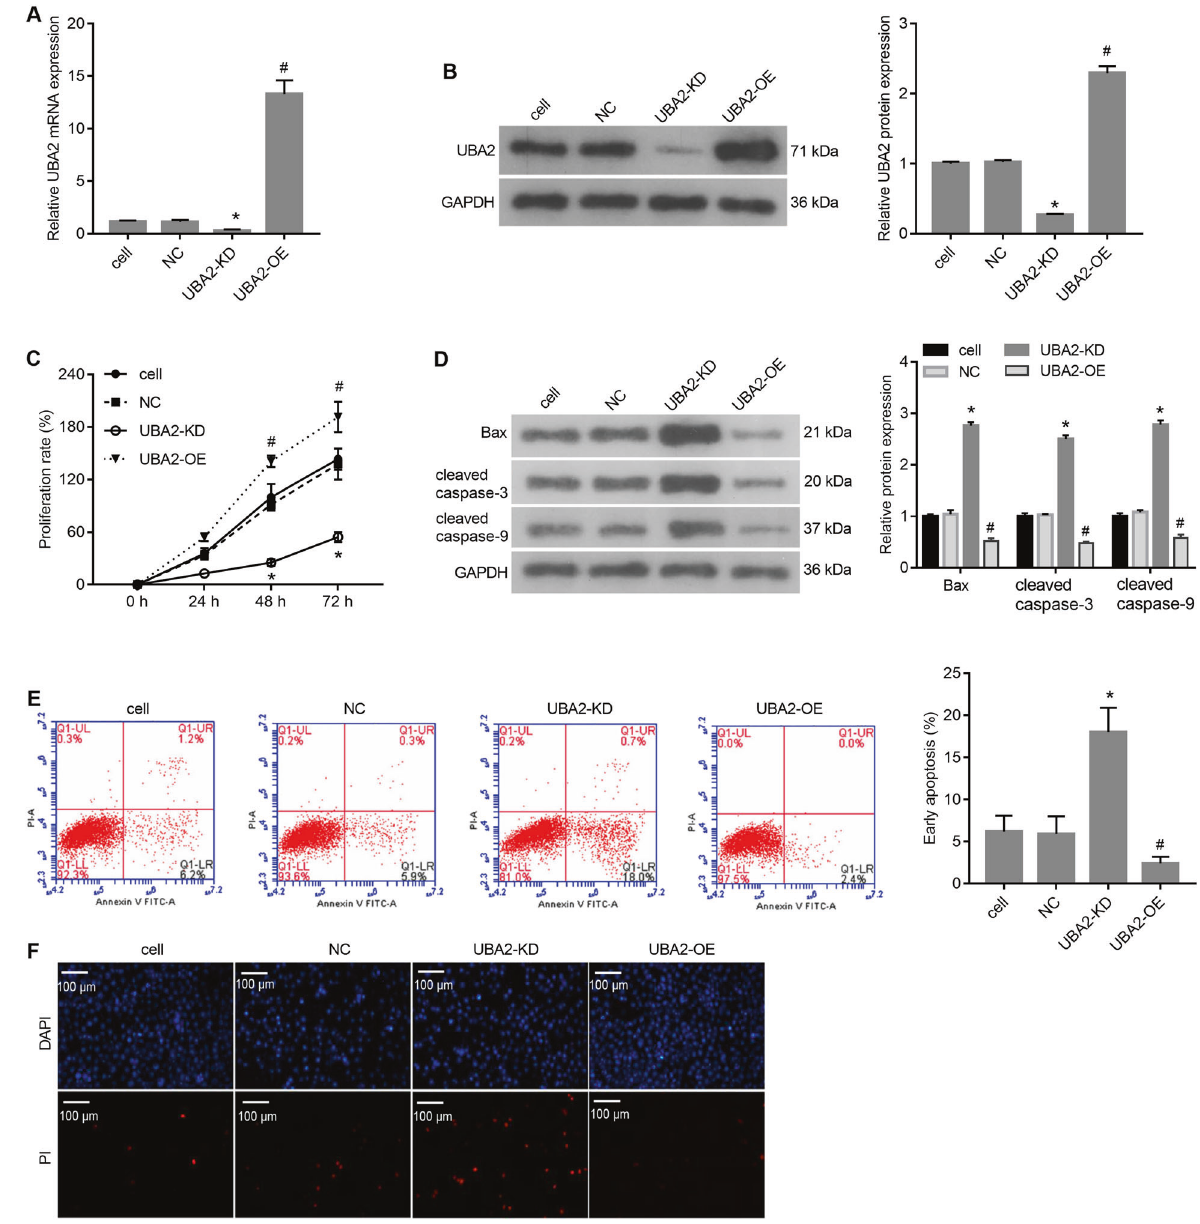
Fig. 2 Effects of UBA2 expression levels on proliferation and apoptosis of 786-O cells in vitro. A mRNA and B protein expression levels of UAB2 in four groups of cells. C Rates of the proliferation of four groups of cells. D Expression levels of proapoptotic proteins in four groups of cells. E Percentages of apoptotic cells measured using the annexin V-FITC/PI assay. F PI staining of four groups of cells. * p < 0.05 UAB2-KD vs. NC; # p < 0.05 UAB2-OE vs. NC. OE overexpression, KD knockdown, NC negative control, DAPI 4 ′ ,6-diamidino-2-phenylindole, PI propidium